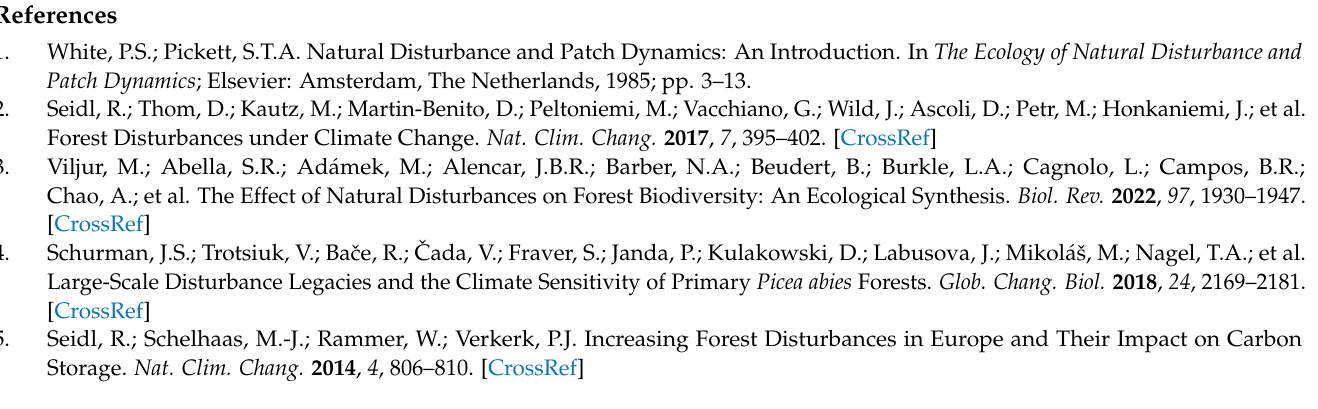
Figure A2. Land cover classes in subarea B (the Jaworzyna range) in the analyzed time period.